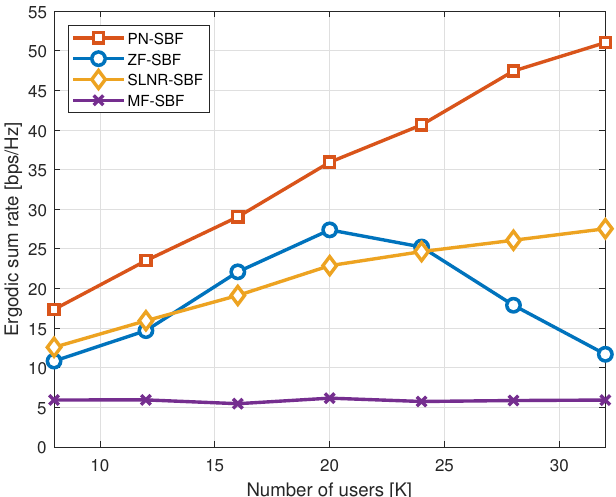
Figure 3. Ergodic sum rate as a function of K , where M = 128, ρ = 10 dB, ∆ H = 10 ◦ , ∆ L = 60 ◦ , K H = K /4, and K H = 3 K /4.